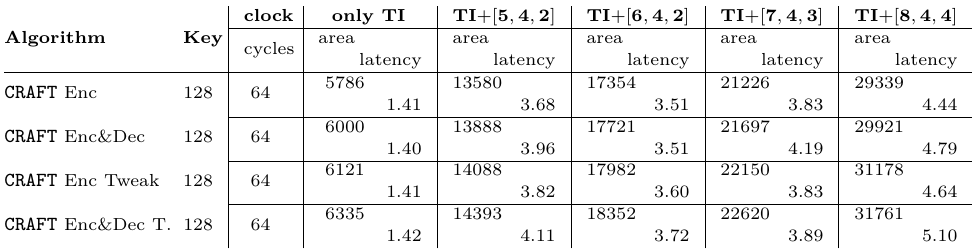
Table 13: Area (GE) and Latency (ns) of round-based Threshold Implementations of CRAFT with 3 shares considering an M ∗ -bounded multivariate adversary with an t = d − 1 [ n, k, d ] code, using a 40 nm commercial ASIC